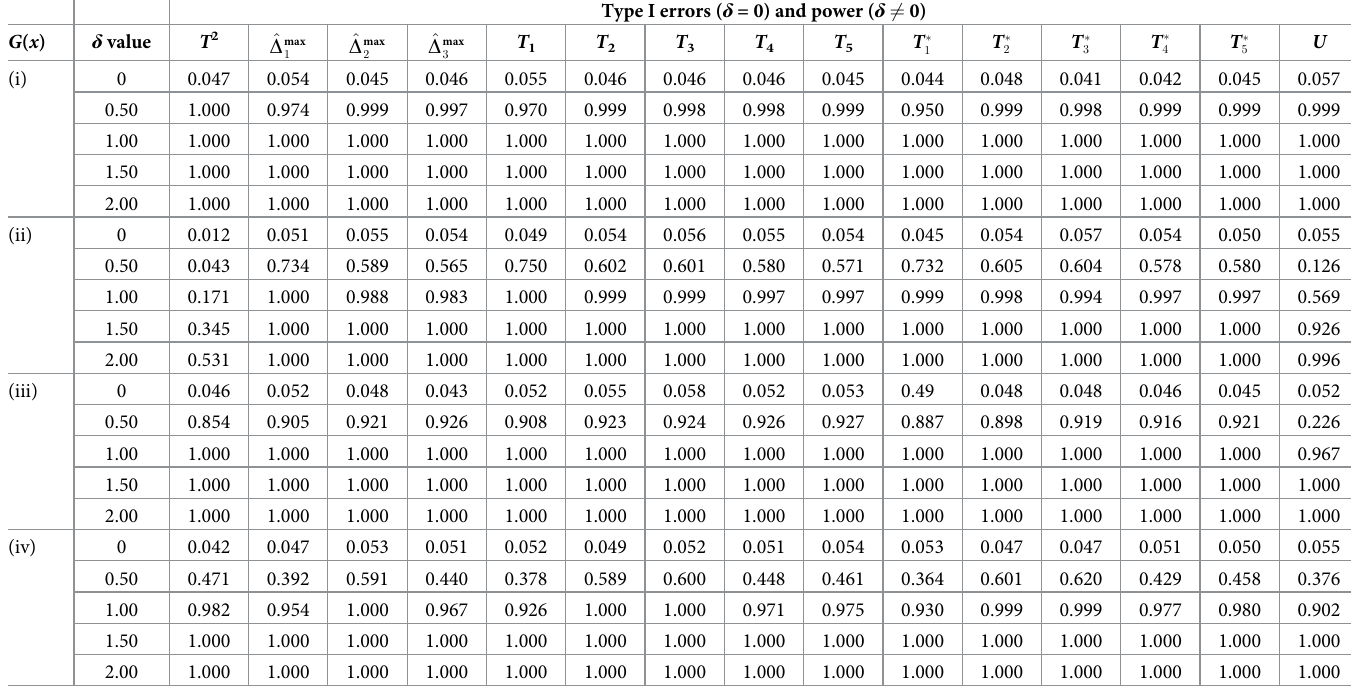
Table 3. Type I errors ( δ = 0) and power ( δ 6¼ 0) given by the investigated test statistics based on permutation approach in detecting location shift between two sam- ples generated from the four pairs of F ( x )and G ( x )with variance-covariance matrix I 4×4 and sample sizes n = m =